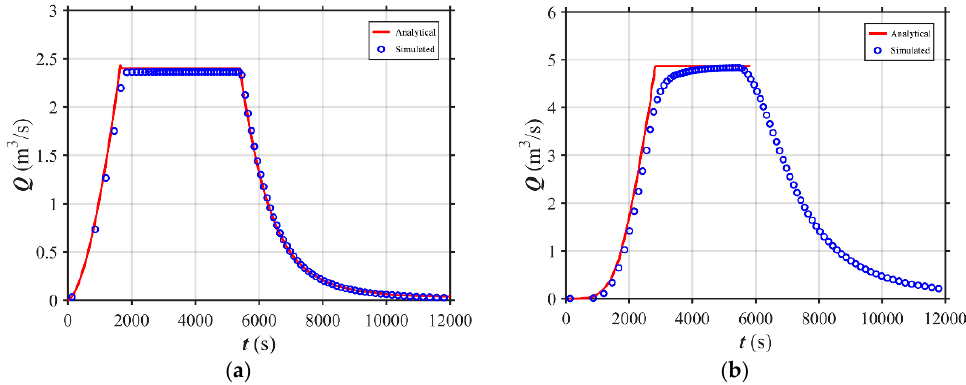
Figure 4. Comparison between the analytical and simulated hydrographs. ( a ) Side slope; ( b ) Channel.